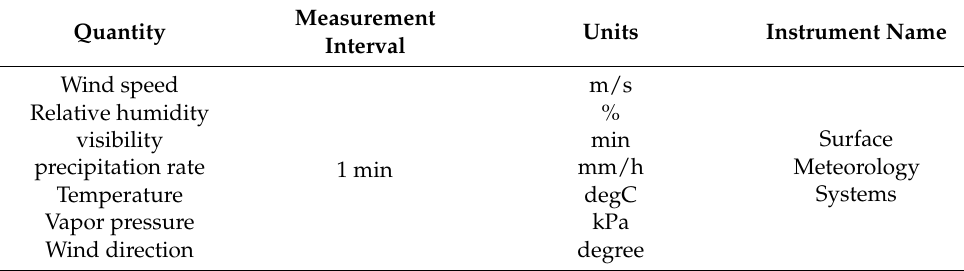
Table 1. Observation elements of surface meteorology systems. Measurement Quantity Interval